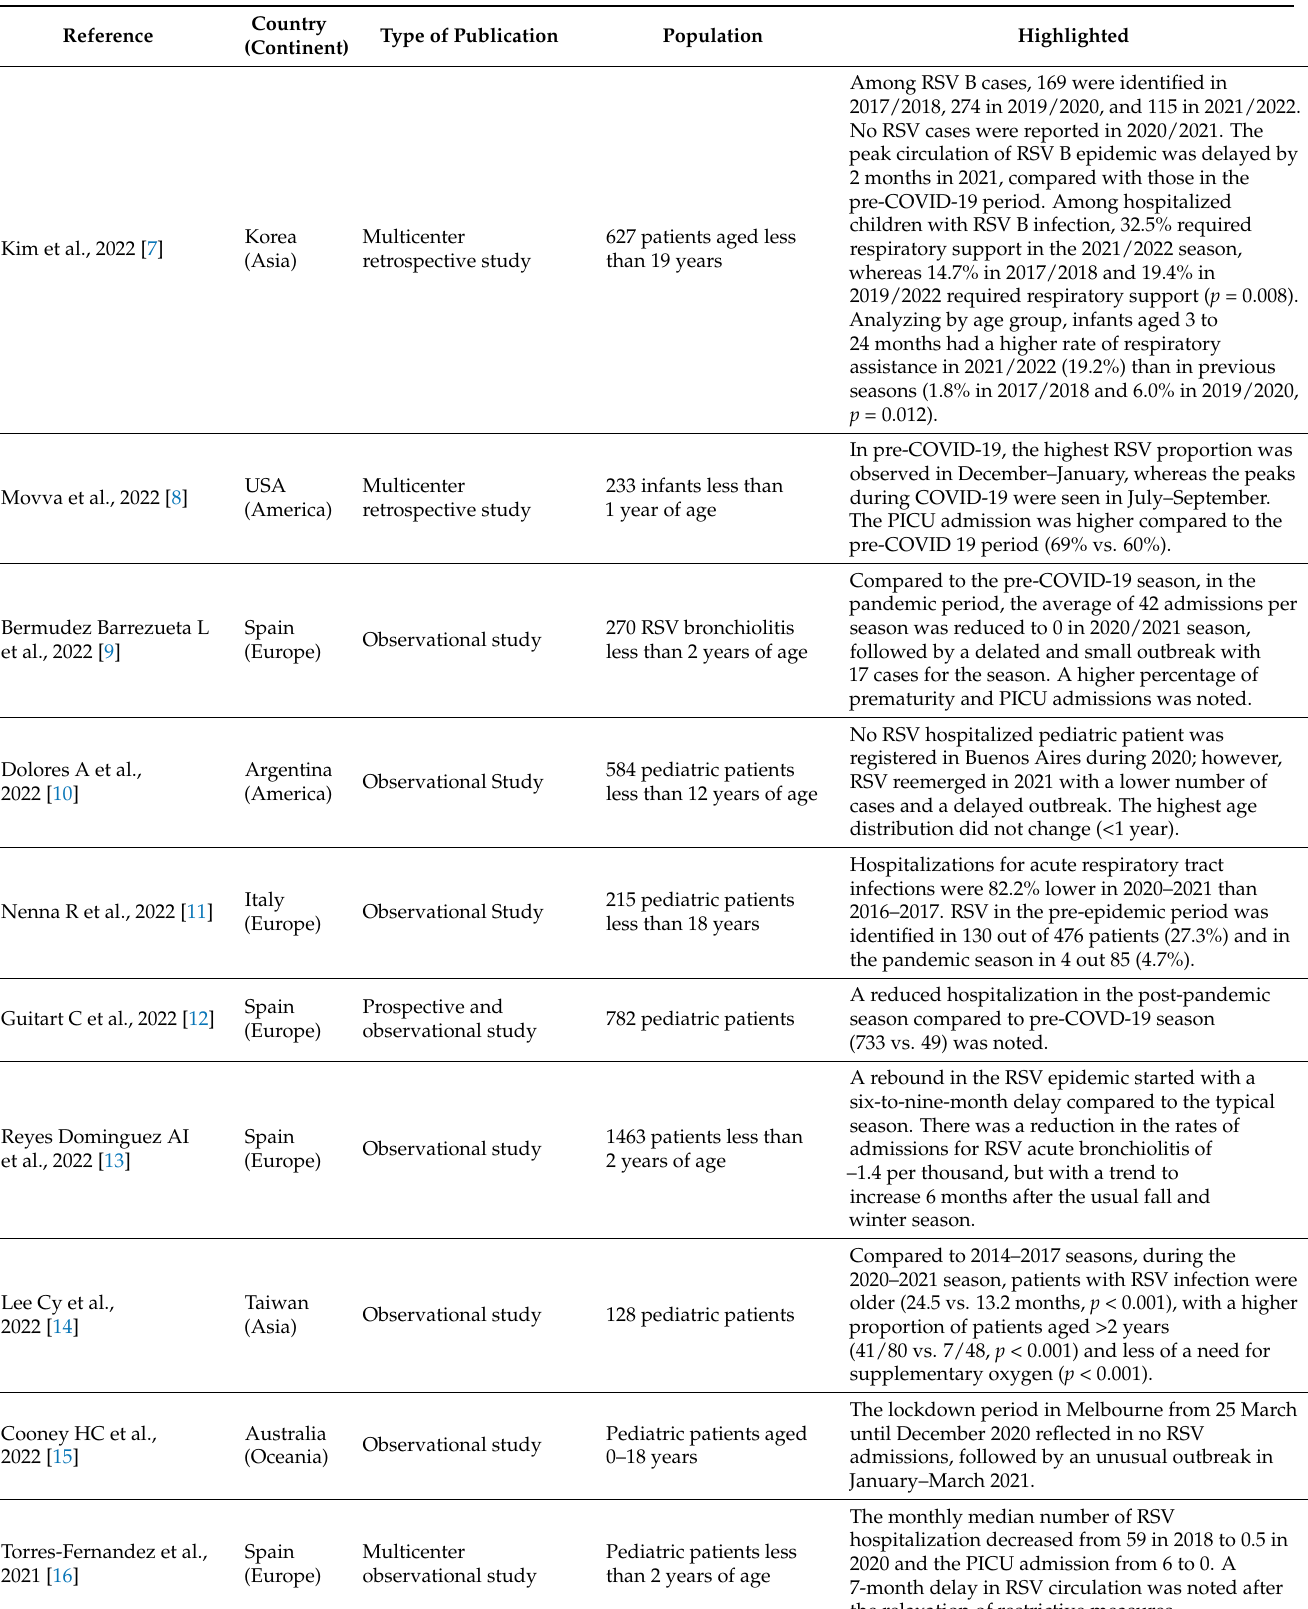
Table 1. Main findings of the reports included in the